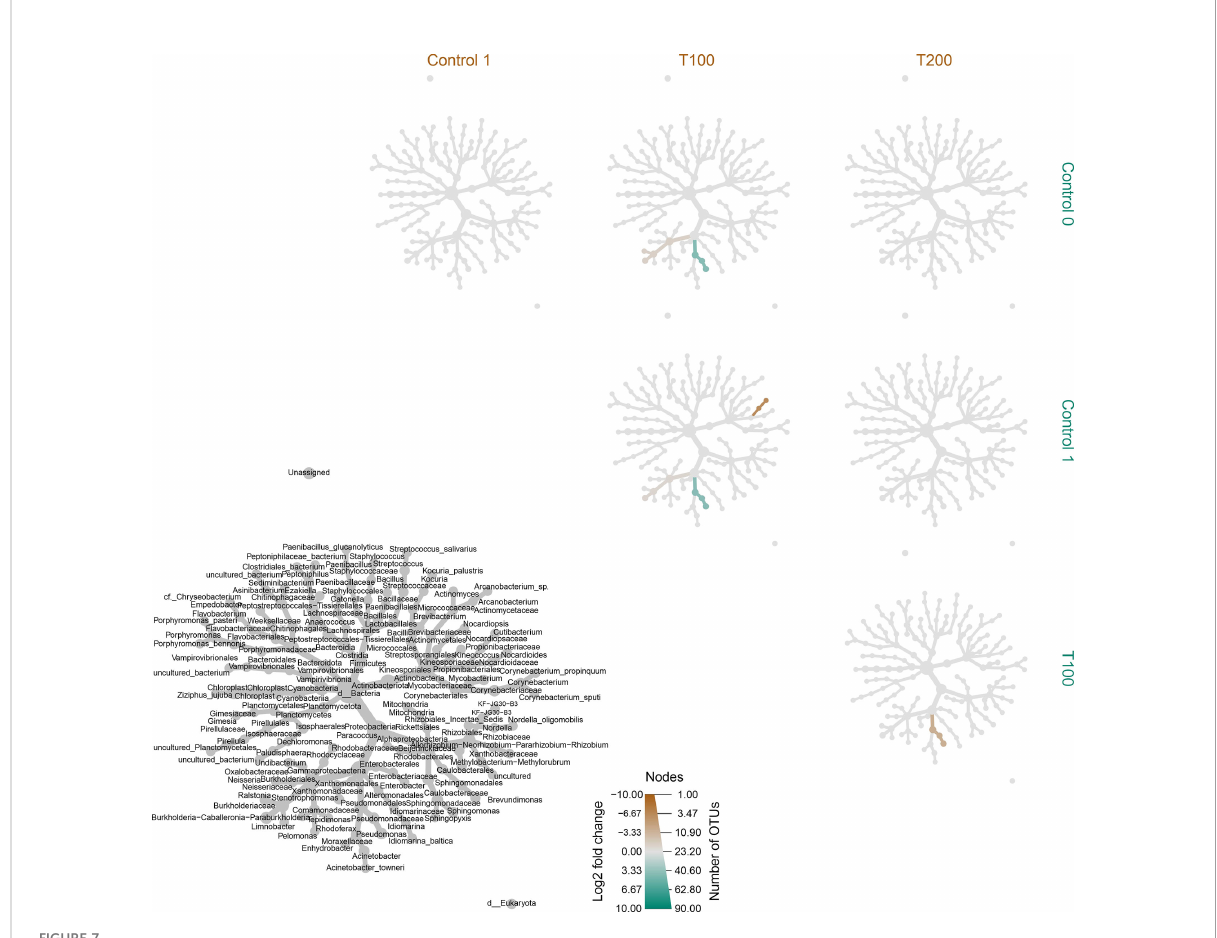
FIGURE 7 Differentially heat tree matrix for pairwise comparisons. Data were classi fi ed on FDR (cutoff = 0.05) and fold change using the r package metacoder (Foster et al., 2017) on samples classi fi ed based on treatment. The grey tree reported at the bottom left side works as a legend for the unlabeled trees. Each smaller tree represents a comparison between treatments in the columns and